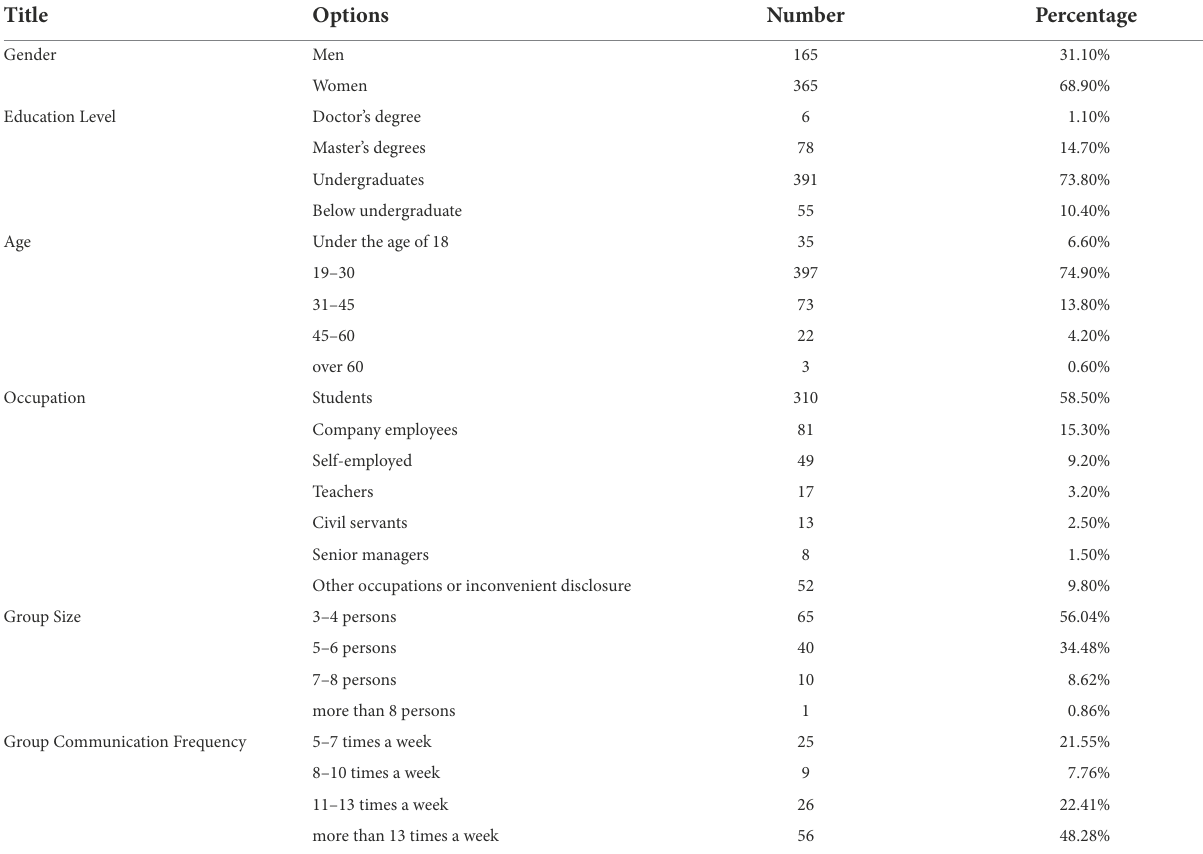
TABLE 1 Basic situation of the